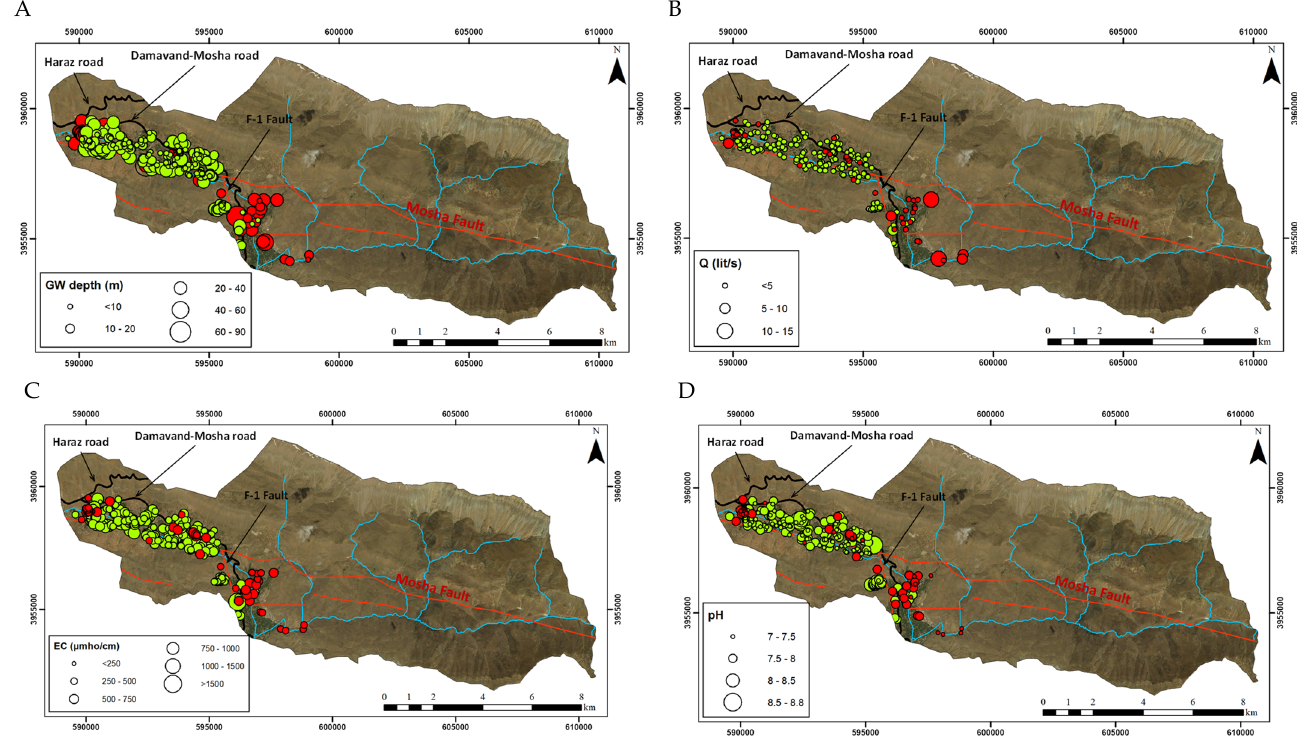
Figure 6. Quantitative and qualitative characteristics of the groundwater abstraction wells in the study area (green and red circles show the wells in the alluvial and fractured rock aquifers, respectively). Solid black lines represent major inter-city roads: ( A ) the groundwater depth in the wells; ( B ) the wells’ yield; ( C ) the groundwater electrical conductivity in the wells; ( D ) the groundwater acidity in the wells.